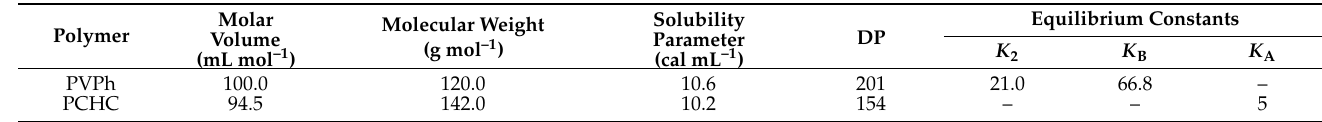
Figure 5. (A): ( a – d ) Curve fitting of the C=O absorptions of selected PVPh/PCHC binary blends, 30/70, 40/60, 60/40, 70/30, relatively; (B): ( e ) Area fractions of the free C=O, intramolecularly H-bonded C=O, and intermolecularly H-bonded C=O groups in PVPh/PCHC binary blends. Table 1. The thermodynamic parameters of PVPh/PCHC binary blends at room